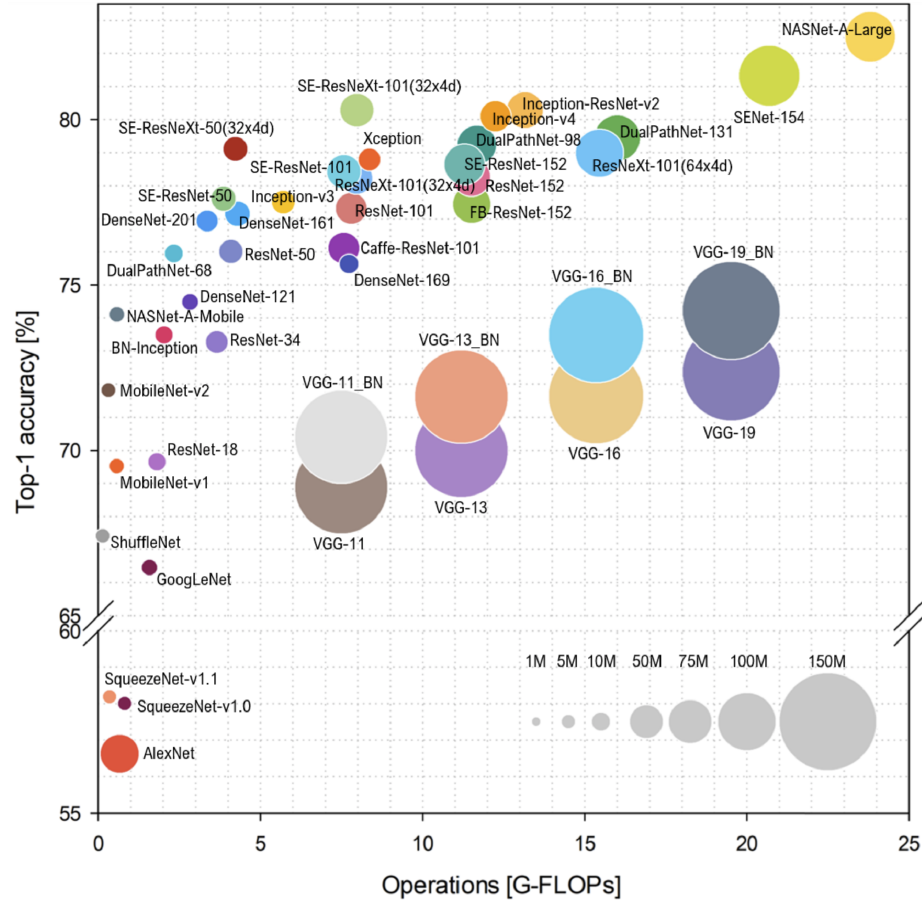
Figure 1. Ball chart reporting the Top-1 ImageNet-1k accuracy vs. computational complexity. The size of each ball corresponds to the model’s complexity. (Reprinted from ref.